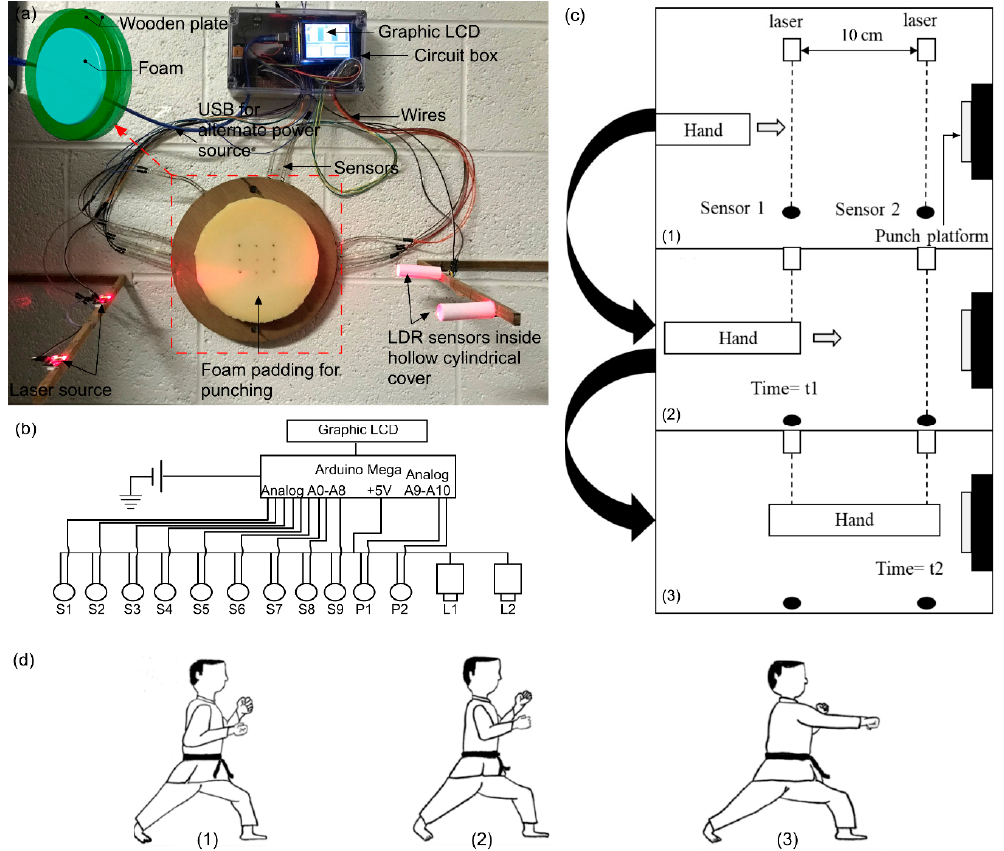
Figure 2. ( a ) Arrangement of the system on the wall and a 3D concept image of the punching structure, ( b ) schematic circuit diagram of the system, ( c ) speed detection module working principle. (1) setup initial position. (2) hand interrupts signal to sensor 1—time t 1 is noted. (3) hand interrupts signal to sensor 2—time t 2 is noted, ( d ) Punching positions of gyaku tsuki style (1) starting, (2) mid, and (3) final